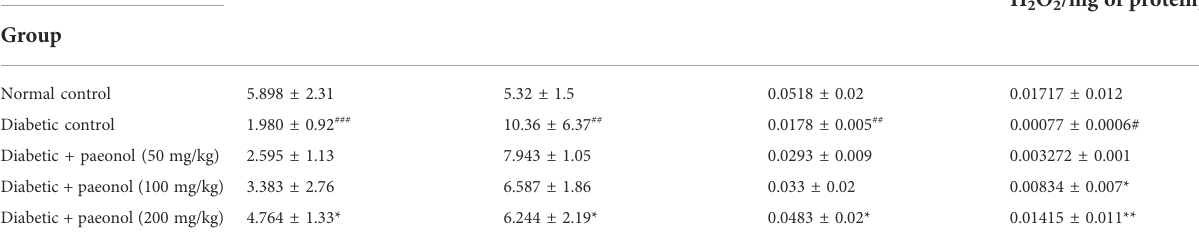
TABLE 2 Effect of paeonol on the oxidative stress parameters in the lens of experimental rats.